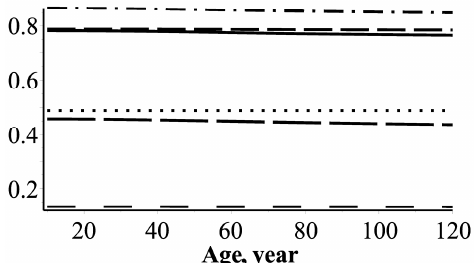
Figure 3. Coefficient of correlation among tree size components: between diameter and height–solid line; between diameter and crown base height—dotted line; between diameter and crown width dash line; between height and crown base height—dashdot; between height and crown width—longdash; between crown base height and crown width—spacedash.